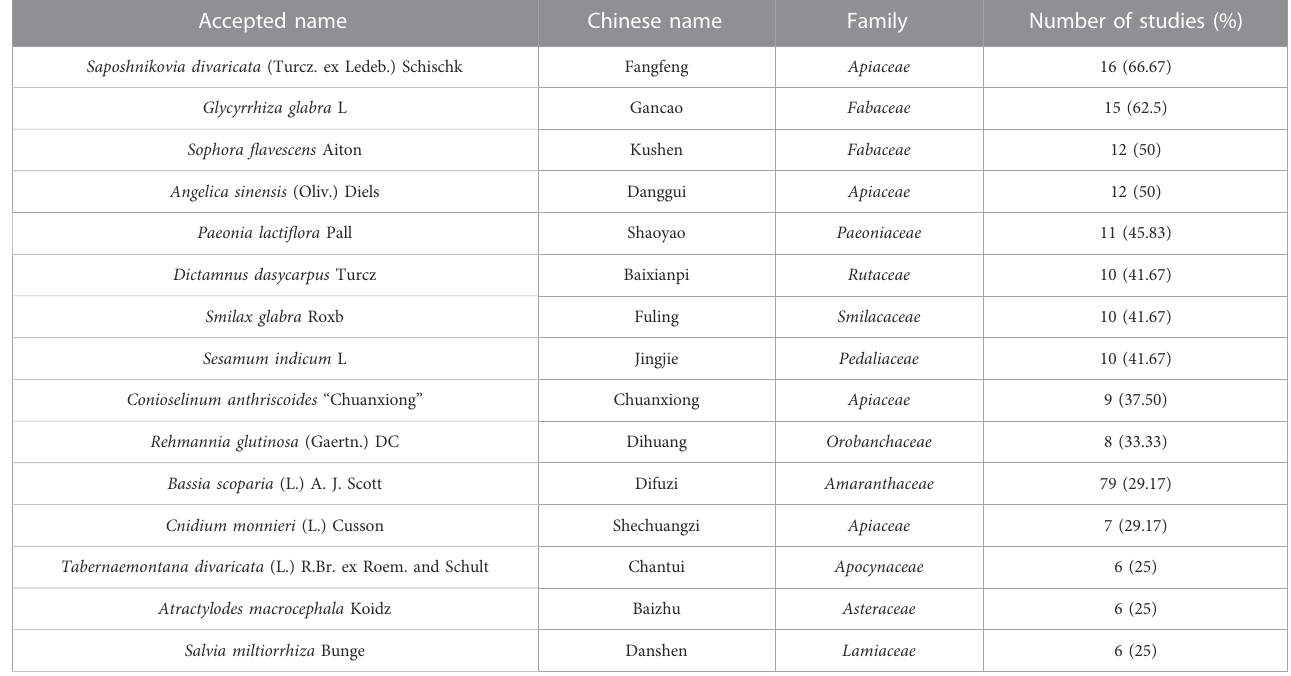
TABLE 5 The 15 most frequently used ingredients of Chinese herbal medicine in 24